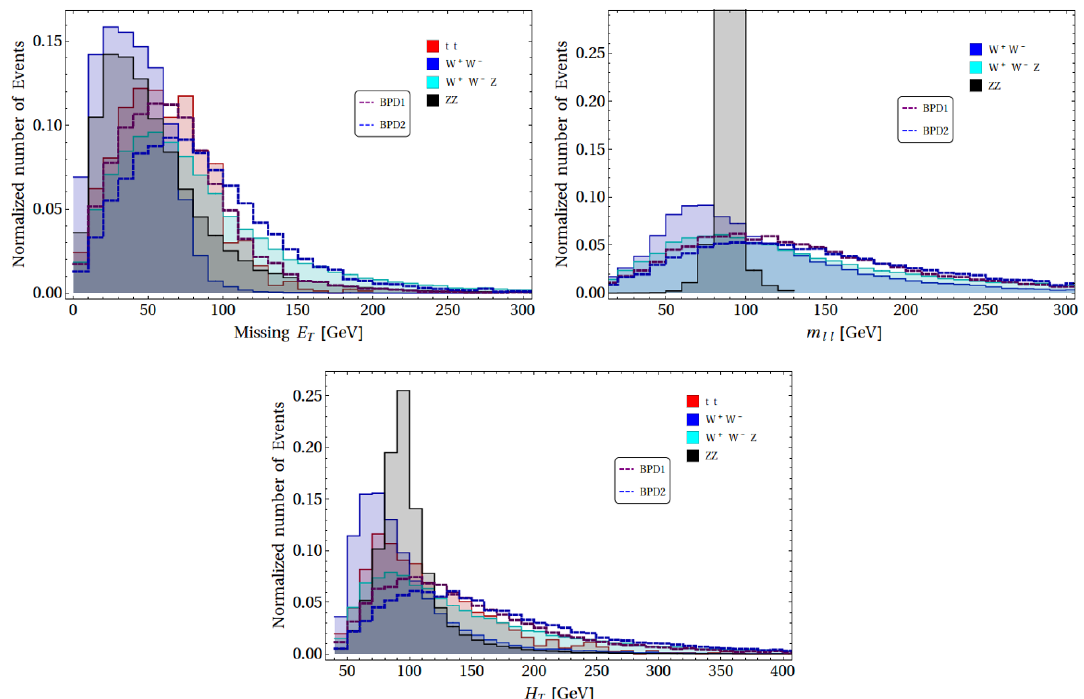
Figure 30 . Distribution of missing energy ( =E verse mass ( H T ) for signal events ‘ + ‘ (cid:0) + ( =E p s = 14 TeV.